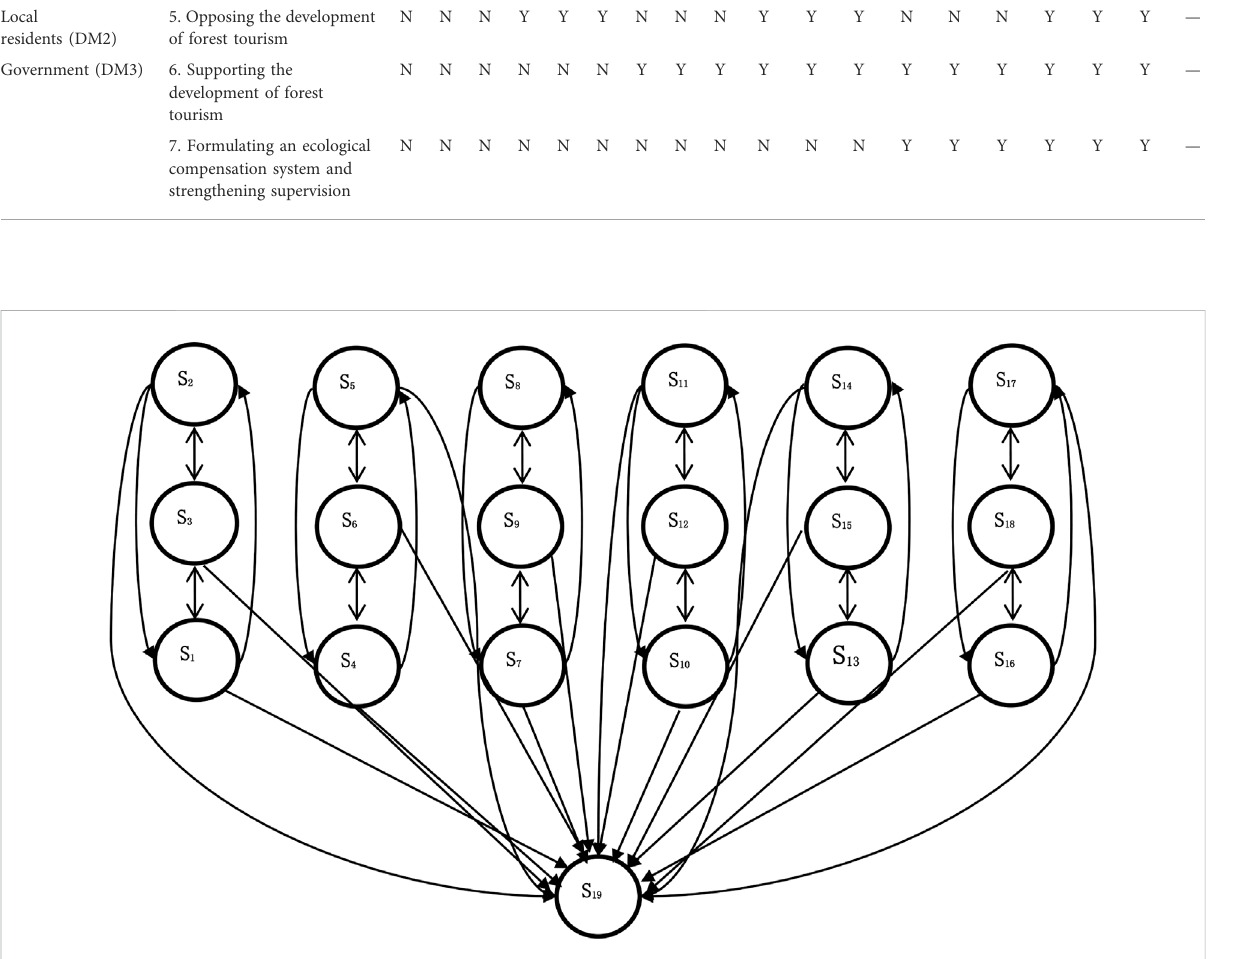
FIGURE 2 Forest tourism enterprise state transition